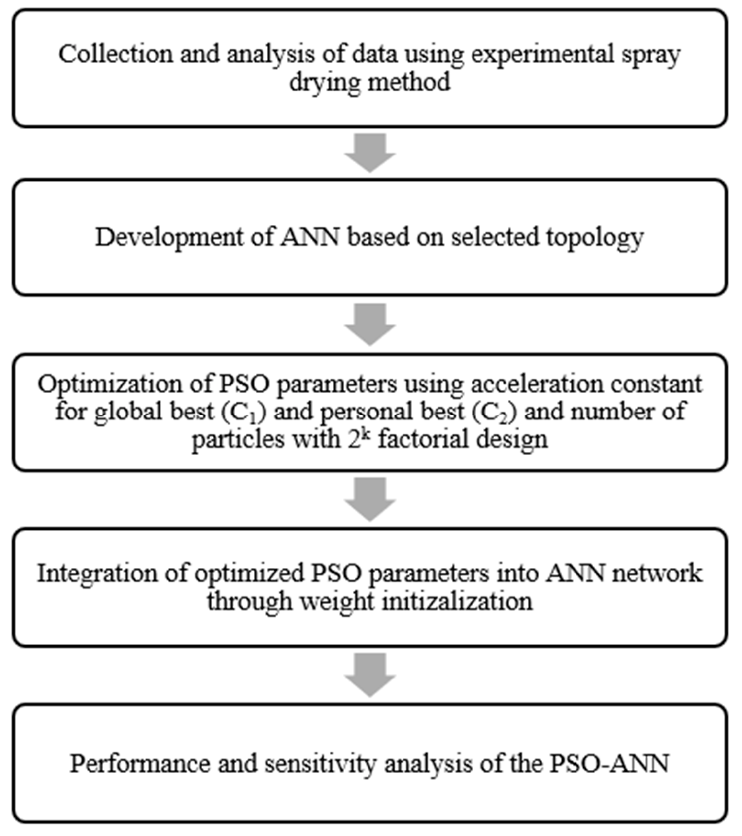
Figure 1. Research framework for PSO development.